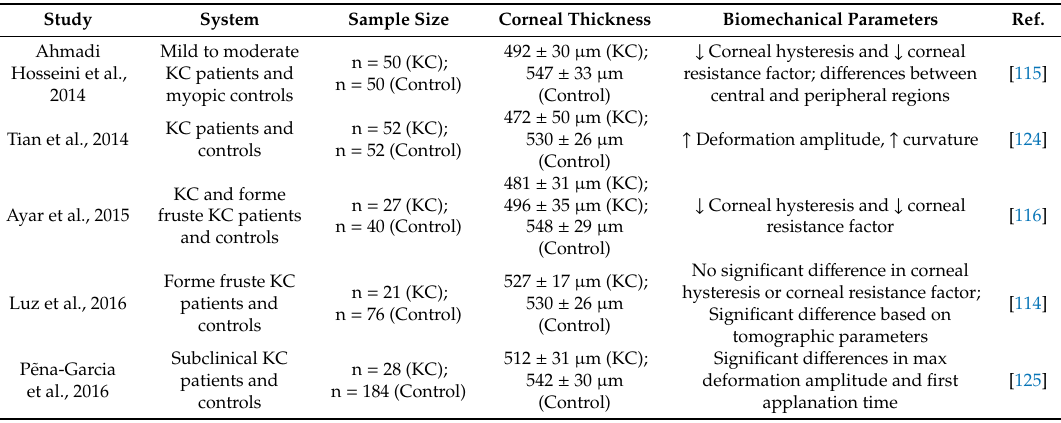
Table 2. E ff ects of KC and forme fruste KC on corneal thickness and biomechanical parameters in human